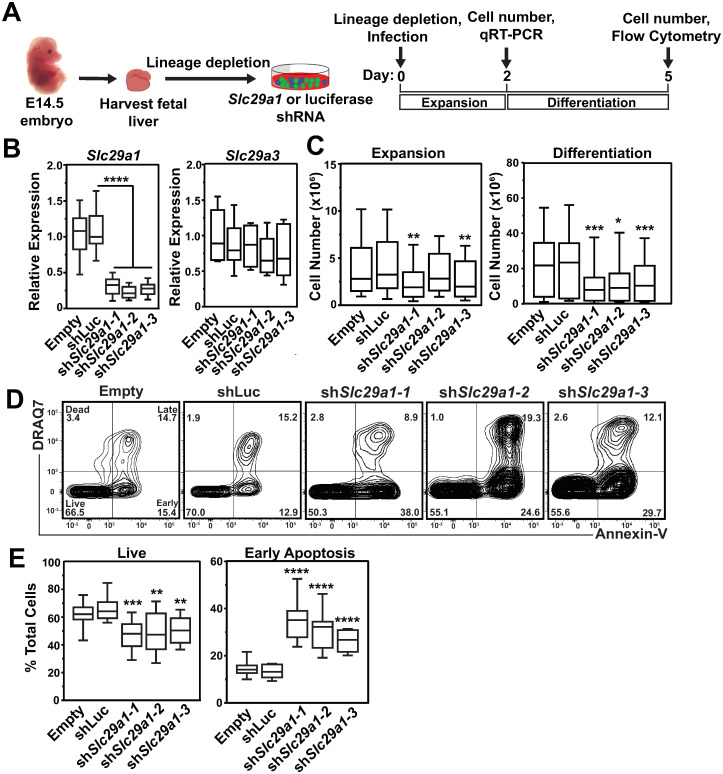
Slc29a1 confers survival during erythroblast differentiation.(A) Experimental strategy. HSPCs from E14.5 fetal livers were infected with Slc29a1 or luciferase shRNAs. Erythroid precursors were expanded for two days followed by three days of erythroid differentiation. (B) qRT-PCR analysis validating Slc29a1 mRNA knockdown efficiency. qRT-PCR analysis of Slc29a1 and Slc29a3 mRNAs. (C) Quantification of live cells after two days of erythroid precursor expansion (left). Quantification of live cells after two days of erythroid precursor expansion followed by three days of erythroid differentiation (right). (D) Flow cytometric analysis of Annexin V and the membrane-impermeable dye DRAQ7 in empty vector, luciferase or shRNA targeting Slc29a1 during erythrocyte differentiation. (E) Quantification of cells in live and early apoptosis flow cytometric gates. n = 12 per condition (4 independent experiments). For the box-and-whisker plots, the box depicts the 25 to 75th percentiles of data, the median line, and whiskers ranging from minimum to maximum values. Statistical analysis was carried out using an unpaired 2-tailed Student’s t test to compare Slc29a1 shRNA- and luciferase shRNA-infected cells. * p < 0.05, ** p < 0.01, *** p < 0.001, **** p < 0.0001.